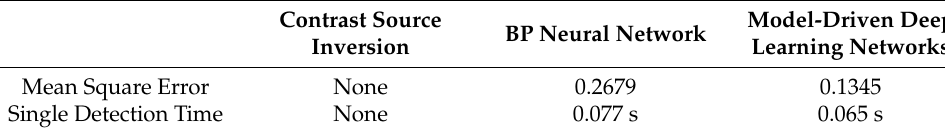
Table 5. Mean square error and average single detection time for each algorithm.